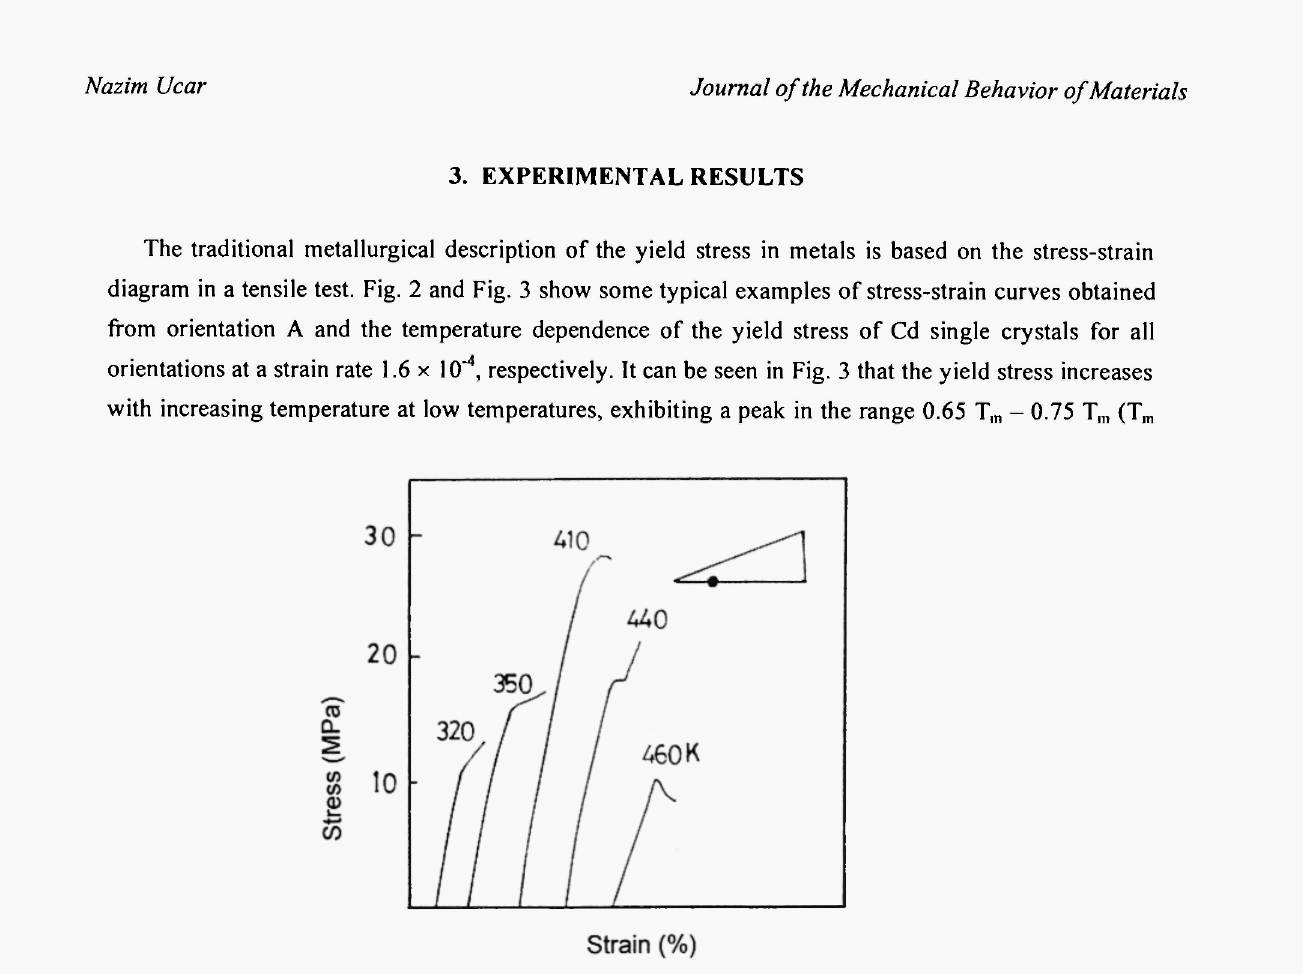
Fig. 2: Typical stress-strain curves of Cd single crystals with orientation A deformed at various temperatures and measured at a strain rate of 1.6 χ 10" 4 s" 1 .